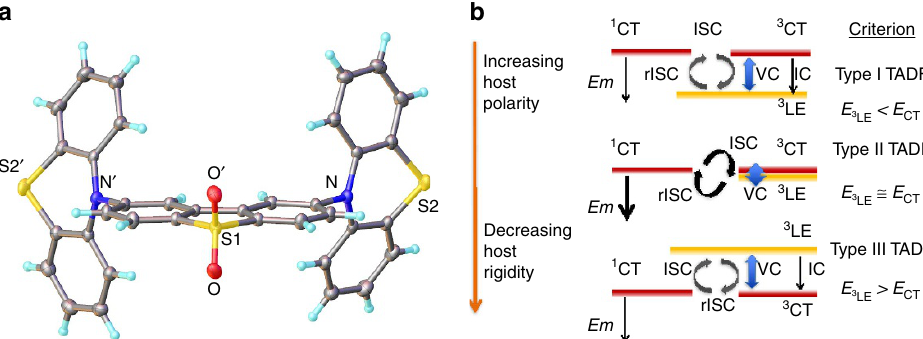
Figure 1 | The X-ray structure of DPTZ-DPTO2 and proposed model for the TADF mechanism in this system. ( a ) The donor–acceptor–donor X-ray structure of DPTZ-DPTO2, (2,8-di(10H-phenothiazin-10-yl)dibenzo[b,d]thiophene 5,5-dioxide). ( b ) The proposed model for the TADF mechanisms in DPTZ-DPTO2, which considers the ISC between 1 CT and 3 LE based on the inhibited intra CT states ISC and rISC. VC represents the vibronic coupling between states. Type I is a system of high rigidity/low polarity so that 3 LE is below 1 CTand Type III is a system of low rigidity/ high polarity where 3 LE is above 1 CT, such that in both cases 3 LE is off-resonance from the CT states. Type II represents the ideal case and the most efficient TADF system where molecular structure and polarity and rigidity controlled energetics are such that 3 LE is on-resonance with the CTstate, giving high efficiency rISC and hence